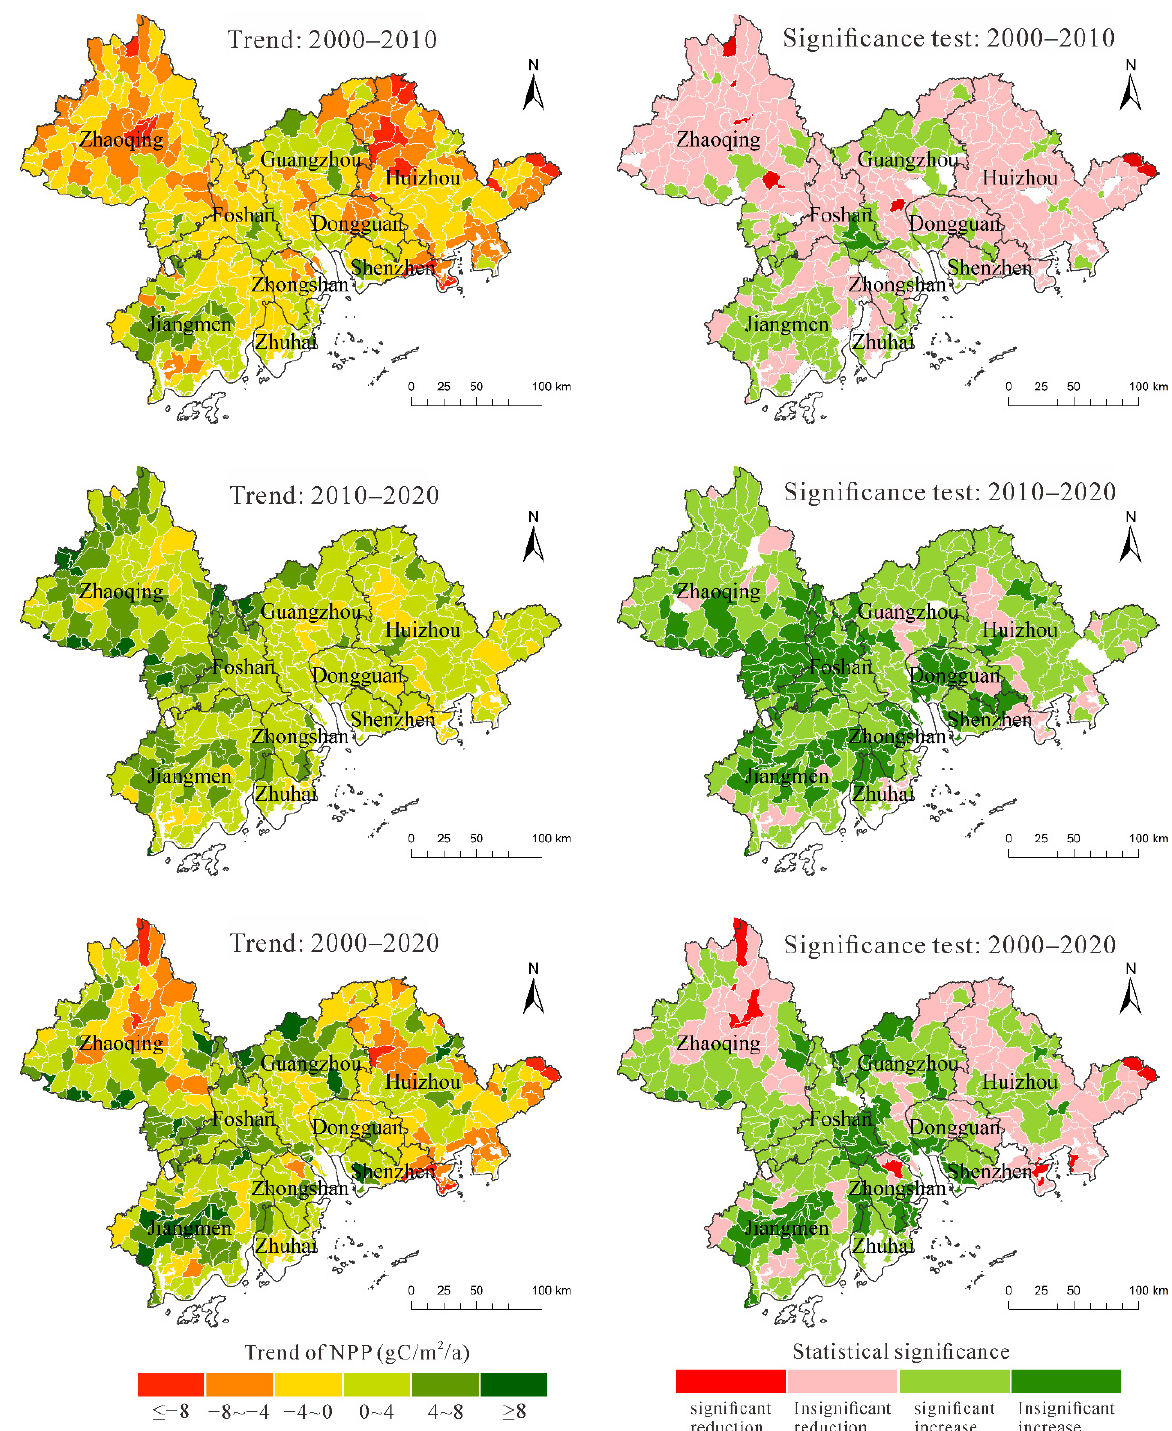
Figure 10. Trend of net primary productivity (NPP) in the Pearl River Delta (PRD) in three time periods.